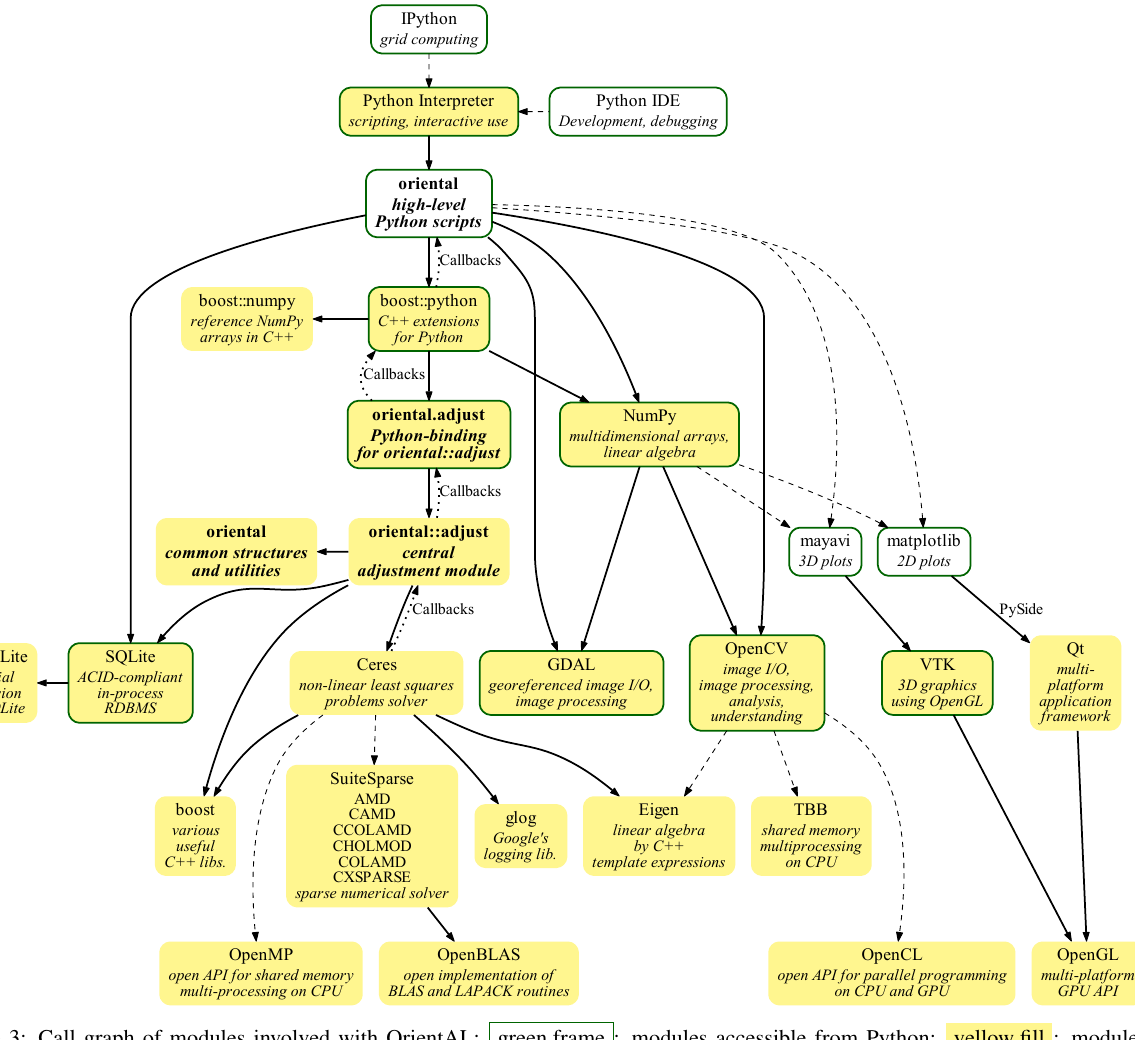
Figure 3: Call graph of modules involved with OrientAL; green frame : modules accessible from Python; yellow fill : modules accessible from C/C++; dashed edges: optional